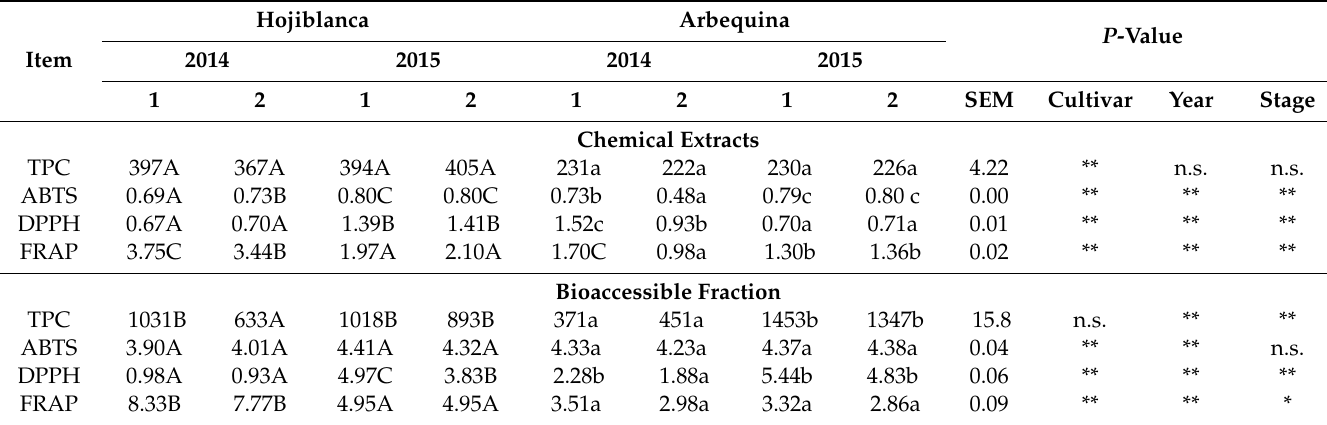
Table 3. Total phenolic content (TPC) and antioxidant activity (ABTS, DPPH and FRAP) determinate in the chemical extracts and bioaccesible fractions in